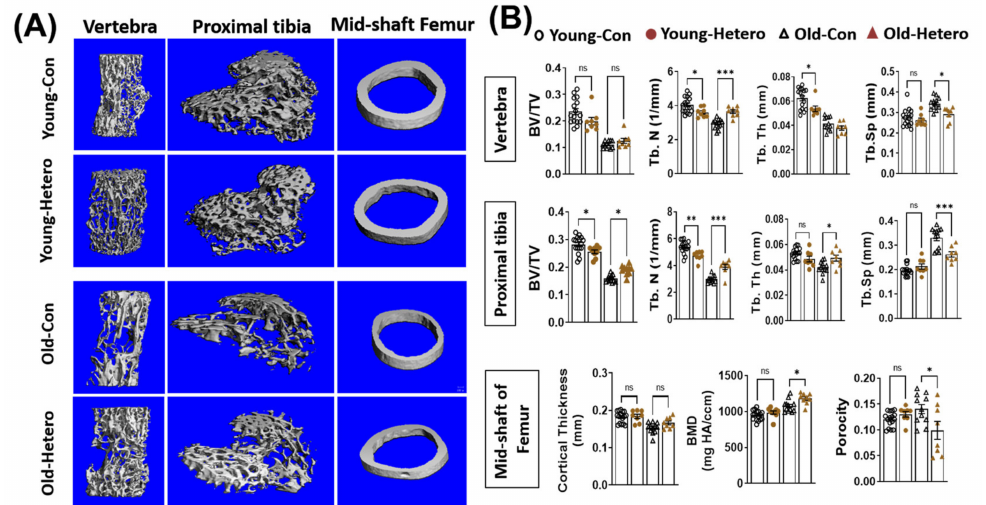
Figure 2. Heterochronic parabiosis reduces bone loss in old dKO-hetero mice. ( A ): Representative 3-D reconstructed images of the L6 vertebra, epiphyseal part of tibia, and mid-shaft of femur. ( B ) Quantification of bone microarchitectural parameters. Young-Con: young mdx mice in